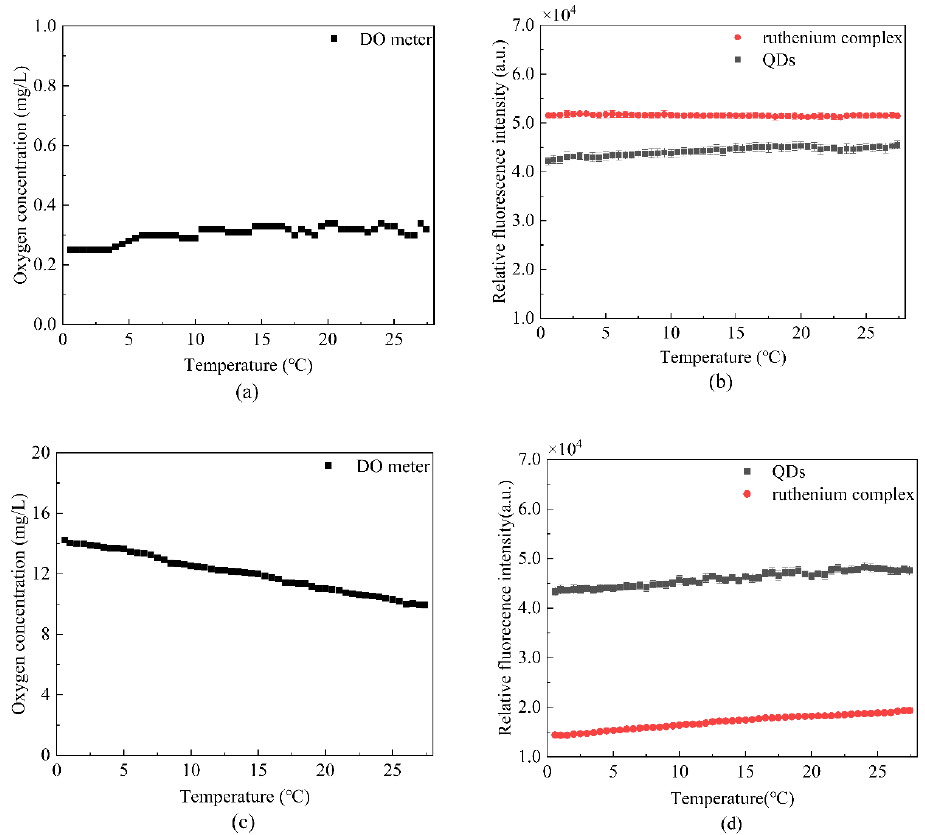
Figure 10. Temperature stability test ( a ) the oxygen concentration of saturated nitrogen solution measured by DO meter at different temperatures, ( b ) the fluorescence intensity fluctuations of ruthenium complex and QDs in saturated nitrogen solution at different temperatures, ( c ) the oxygen concentration of saturated oxygen solution measured by DO meter at different temperatures, and ( d ) the fluorescence intensity fluctuations of ruthenium complex and QDs in saturated oxygen solution at different temperatures.